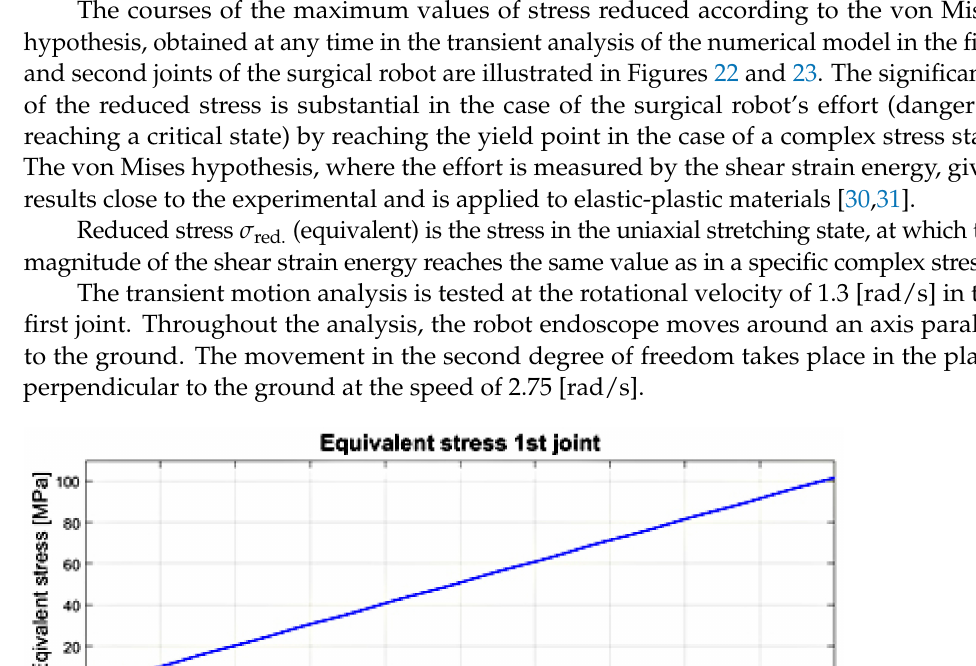
Figure 21. Waveform of the driving torque in the second joint from the dynamics model of the surgical robot in the Simulink.